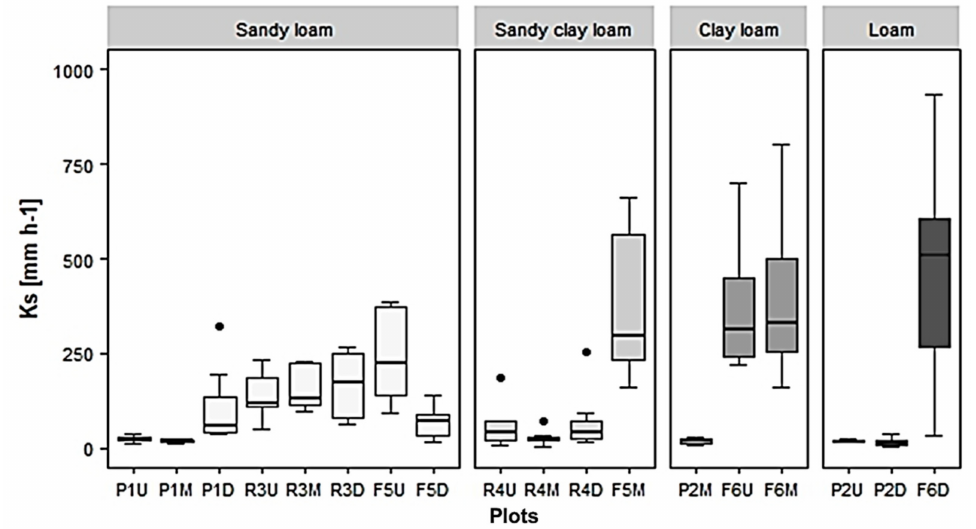
Figure 4. K s estimated with SSBI method, K sS , per plots and grouping by soil texture (US Department of Agriculture (USDA) classification system). Study sites are abbreviated with P1 and P2 for pasture, R3 and R4 for restored forest, and F5 and F6 for remnant forest. The subscript letter refers to the landscape position (Upslope, Middleslope and Downslope) in each